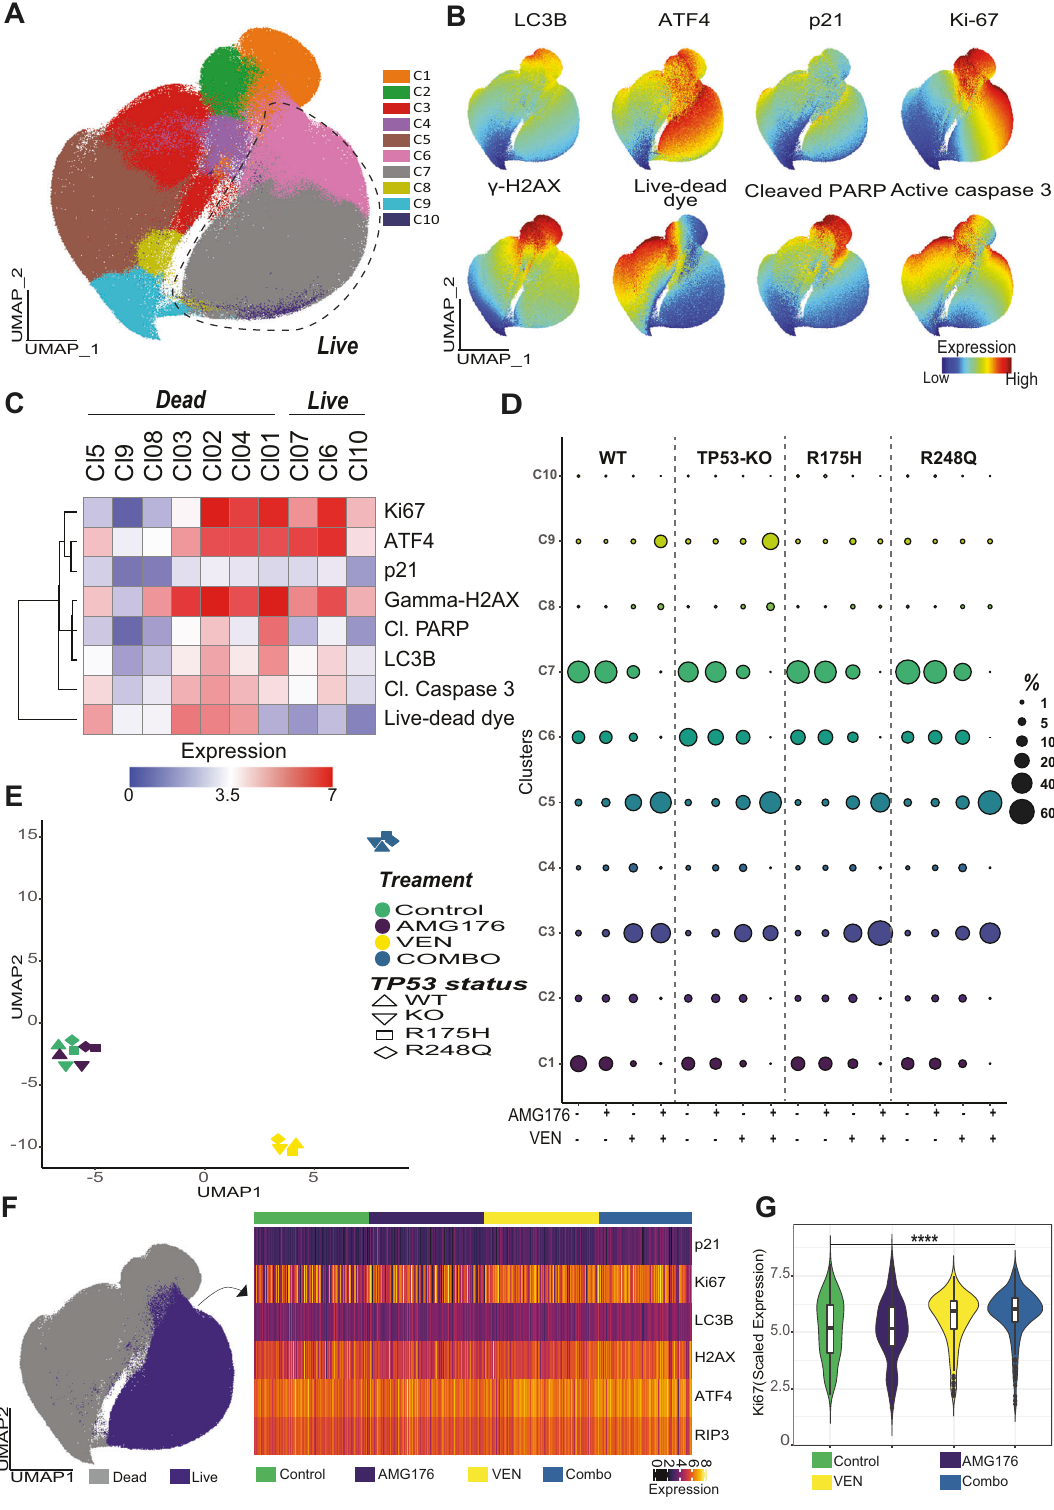
reduced cell viability (Fig. 5B) compared with either agent alone. The combination of synergistically induced cell death in both CD45 + leukemia blasts and CD34 + stem/progenitor cells (Fig. 5C, patients #26 and #28). The CI values of all eight patient samples in leukemia blasts (0.04 ± 0.04 to 0.34 ± 0.10) and